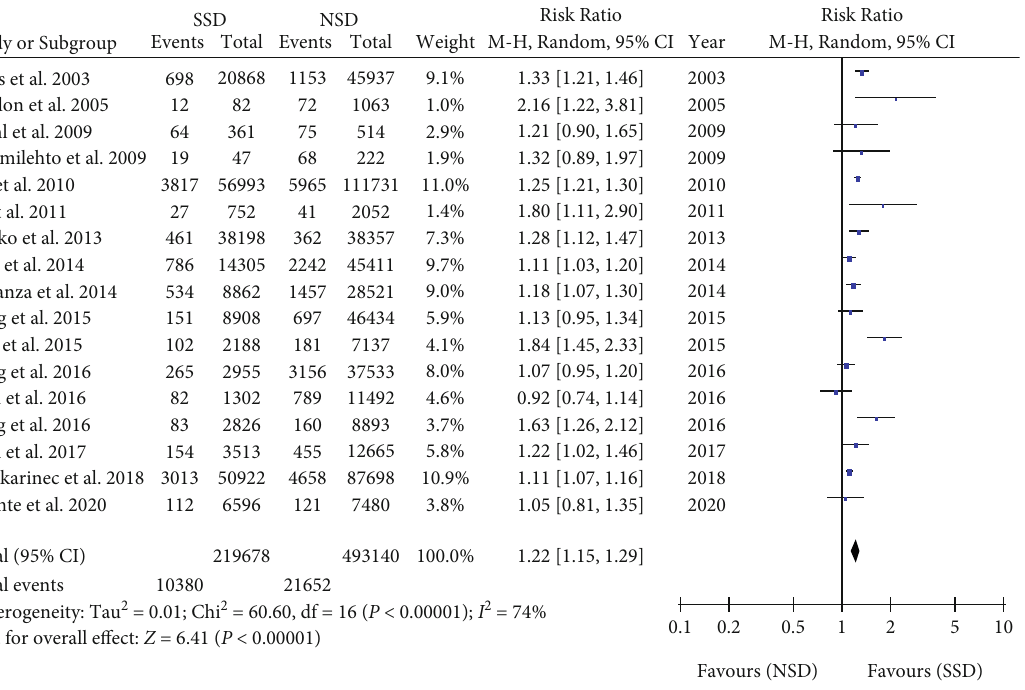
Figure 2: Pooled results for the association between SSD and